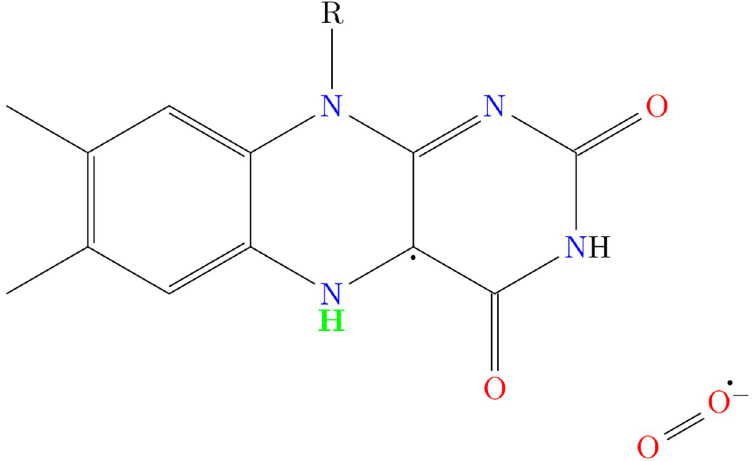
Fig 2. [FADH • ... O 2• − ] RP. H5 nucleus, which has the largest magnitude for isotropic HFCC among all the nuclei in FADH • is highlighted in